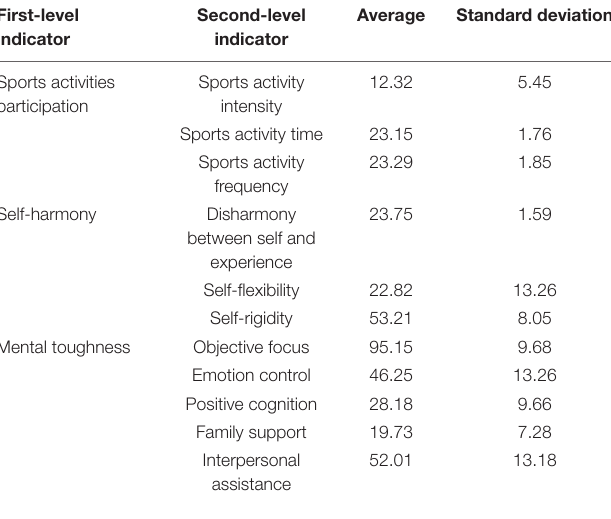
TABLE 2 | Demographic results.